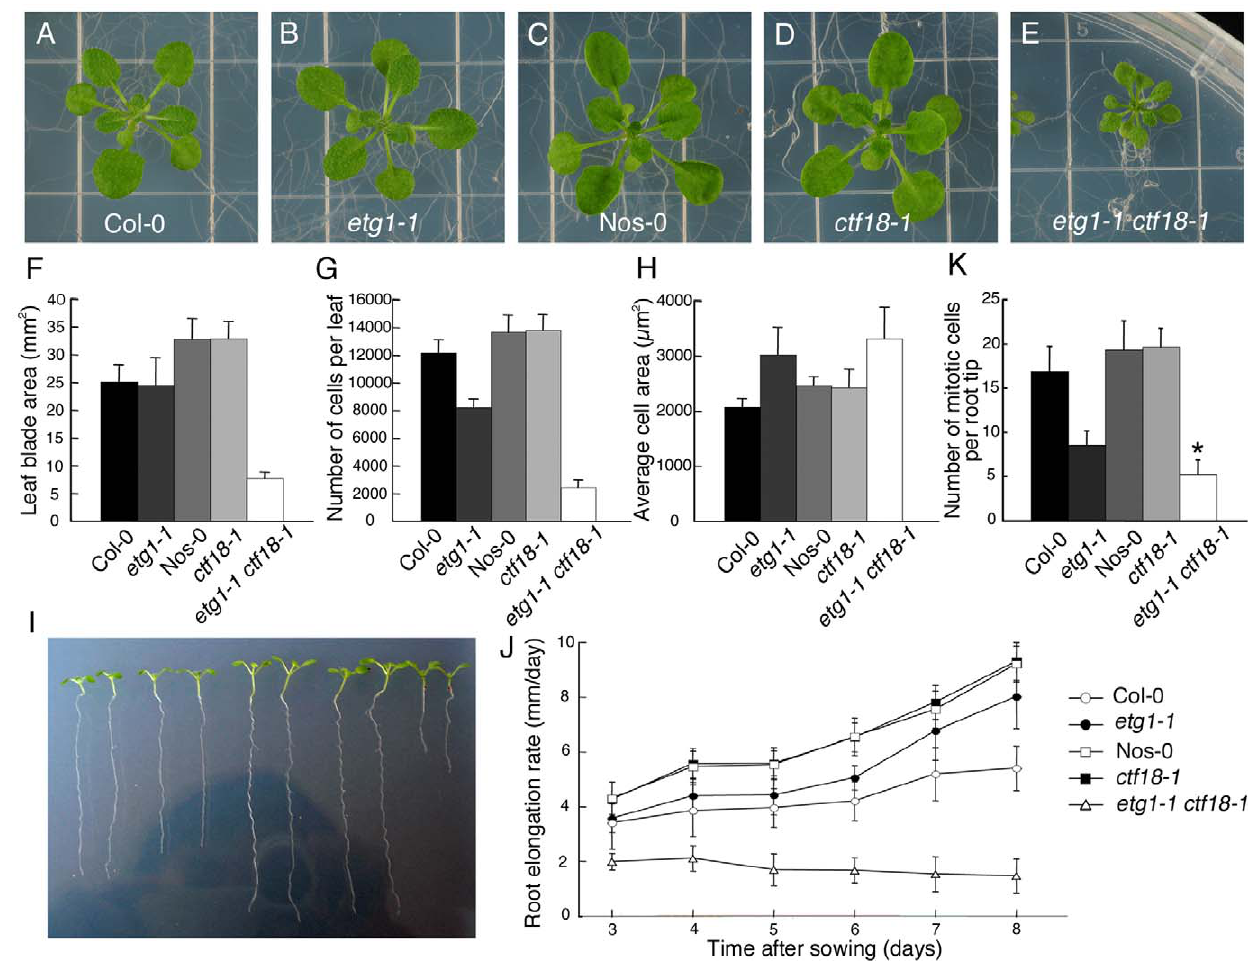
Figure 4. Inhibition of plant growth by loss of sister chromatid cohesion. (A–E) Seedling phenotypes of 21-day-old wild-type (Col-0) (A), etg1-1 ( B ), wild-type (Nos-0) (C), ctf18-1 (D), and etg1-1 ctf18-1 (E) grown on MS plates. (F-H) Leaf growth of the first leaf pair of wild-type (Col-0), etg1- 1 , wild-type (Nos-0), ctf18-1 , and etg1-1 ctf18-1 plants. Leaf blade area (F), epidermal cell number (G), and average epidermal cell size (H) on the abaxial side of the leaf. Data represent average 6 SD (n=5). (I) Root phenotype of 8-day-old wild-type (Col-0), etg1-1 , wild-type (Nos-0), ctf18-1 , and etg1-1 ctf18-1 plants grown on MS plates (two plants each). (J) Kinematic root growth analysis of the root elongation rate of wild-type (Col-0), etg1-1 , wild- type (Nos-0), ctf18-1 , and etg1-1 ctf18-1 plants. Plants were grown on MS agar plates. Data represent average 6 SD (n=20). (K) Number of mitotic cells per root tip of 7-day-old wild-type (Col-0), etg1-1 , wild-type (Nos-0), ctf18-1 , and etg1-1 ctf18-1 seedlings. Data represent average 6 SD (n=20 to 30). Asterisk marks statistically significant differences by Student’s t -test (P-value ,